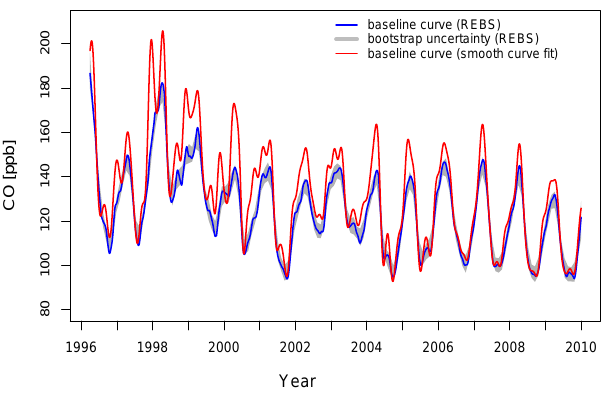
Fig. 3. Baseline curves for CO at Jungfraujoch (1996 to 2009) ob- tained with the REBS technique (including the bootstrapped 95% confidence band) and the smooth curve fit. The average width of the confidence band (bootstrap uncertainty) is ( − 3.5ppb,